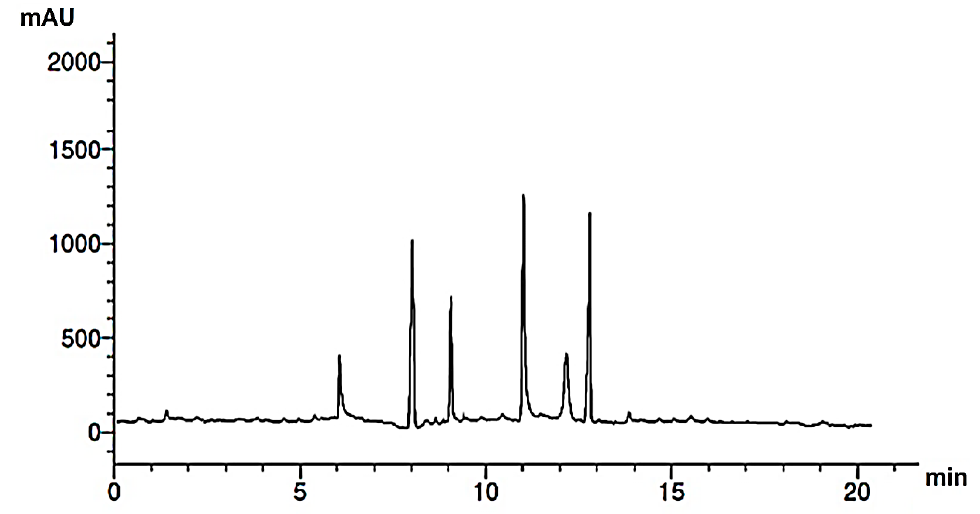
Figure 2. GC-MS chromatogram analysis of M. pulegium extract.